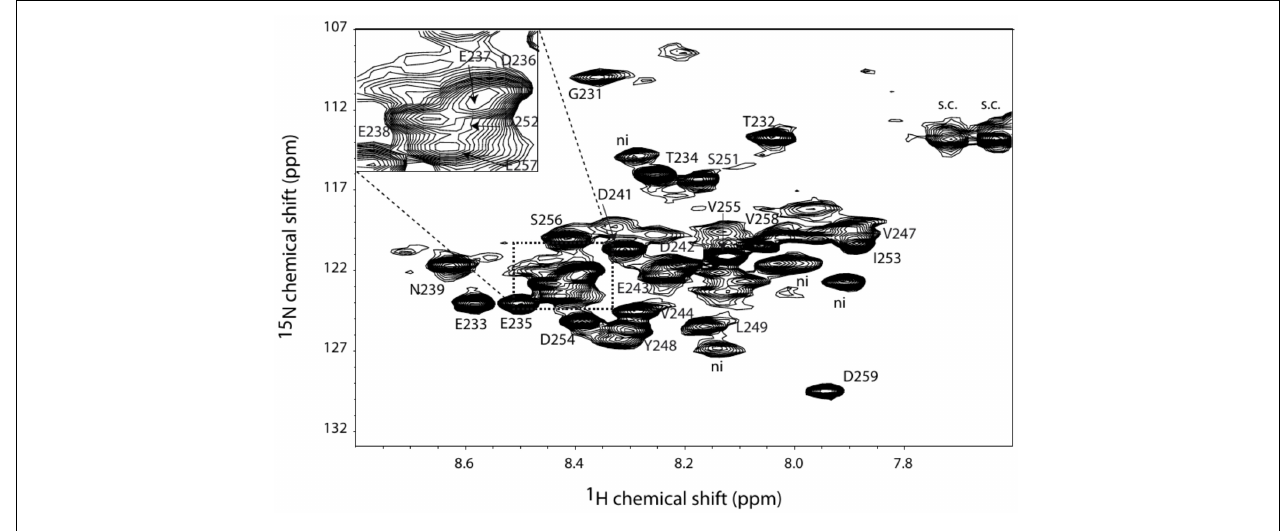
FIGURE 8 | 1 H- 15 N correlation spectrum of PAP9 with the assigned amino acid residue labels annotated “ni” standing for not